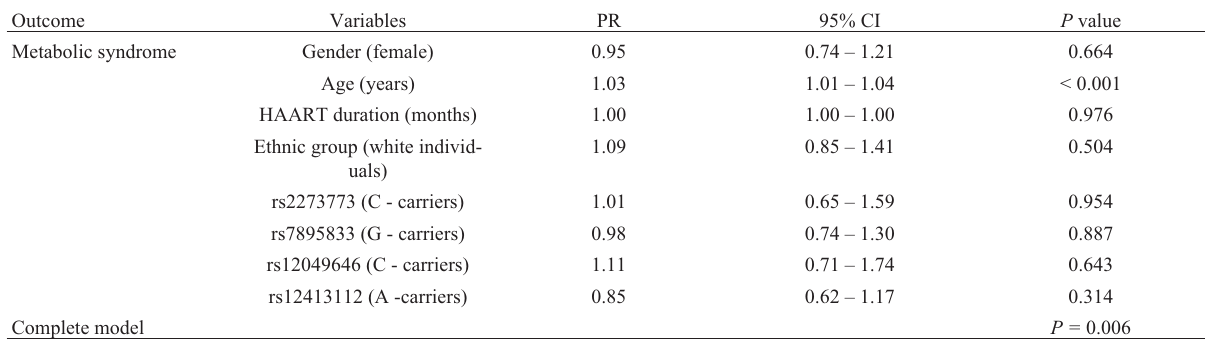
Table 4 - Poisson regression model and predictive variables for metabolic syndrome (MetS) development in HIV-infected individuals on HAART. Outcome